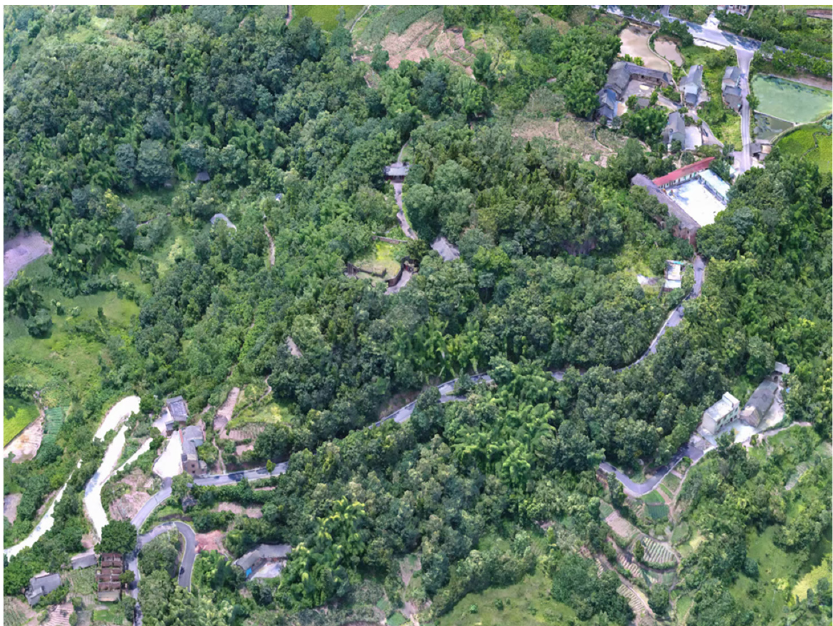
Figure 5. LOD0—The macro-scene in which the cultural relic is located was collected in 2015. A visualized 3D model was created by Beijing Digsur Science and Technology Co., Ltd. (Beijing, China) using the oblique photogrammetry technique with UAV data. Data was collected by UAVs, and dense point clouds were generated by oblique photography. Triangular mesh models were then constructed with textures.